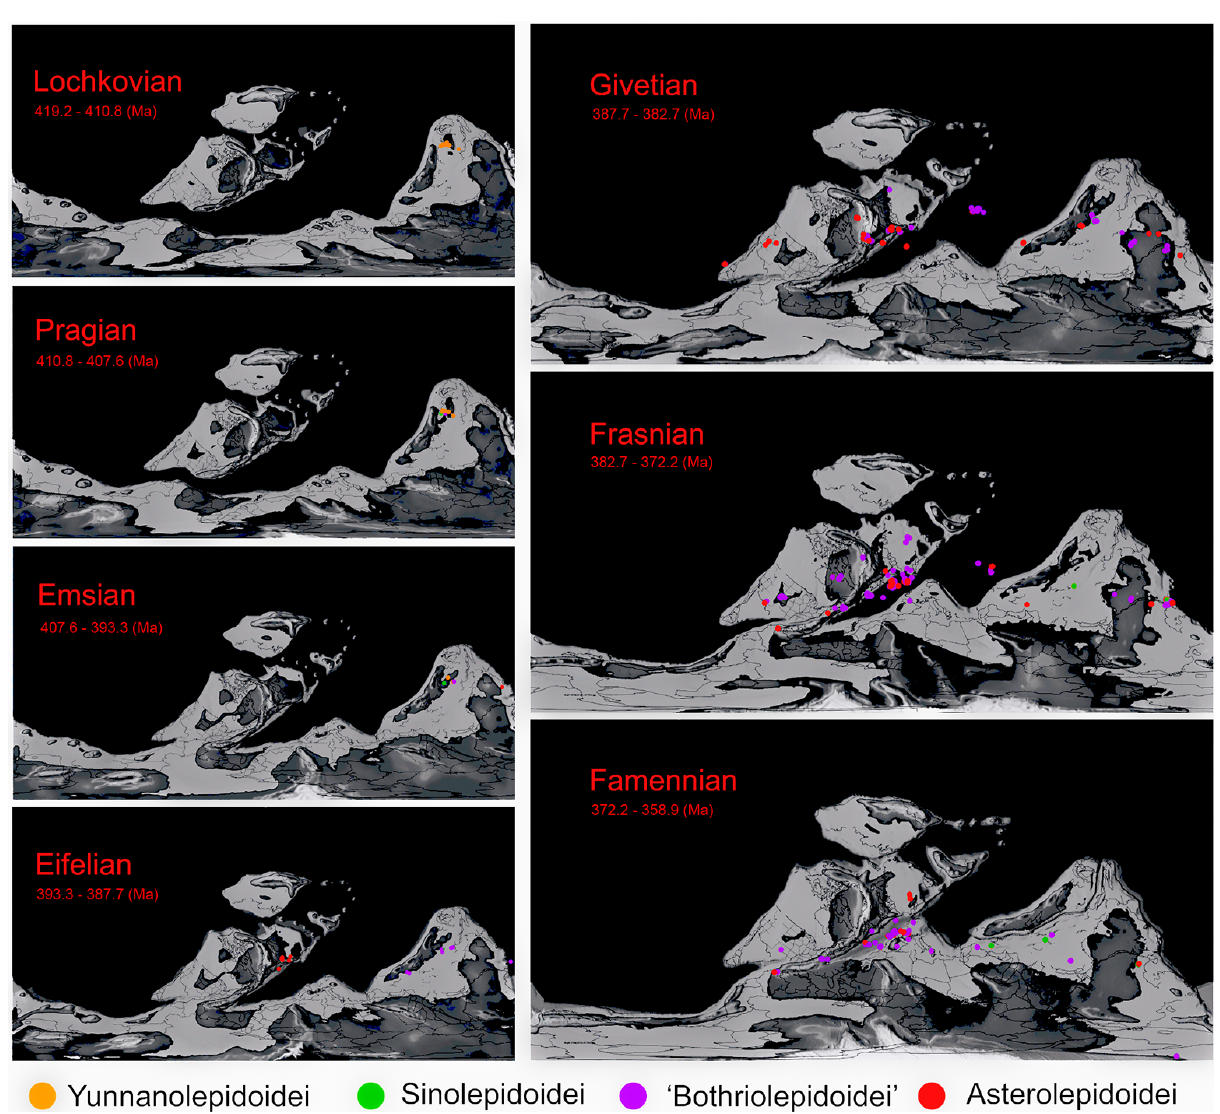
Figure 6. The distributions of Antiarcha during Devonian. Each spot represents the location of one specimen on the paleogeographic map. Specimens from the same locality and the same age overlap each other. The paleo-coordinates are calculated by TrackPoint. Colors denoting respective groups follow Fig.